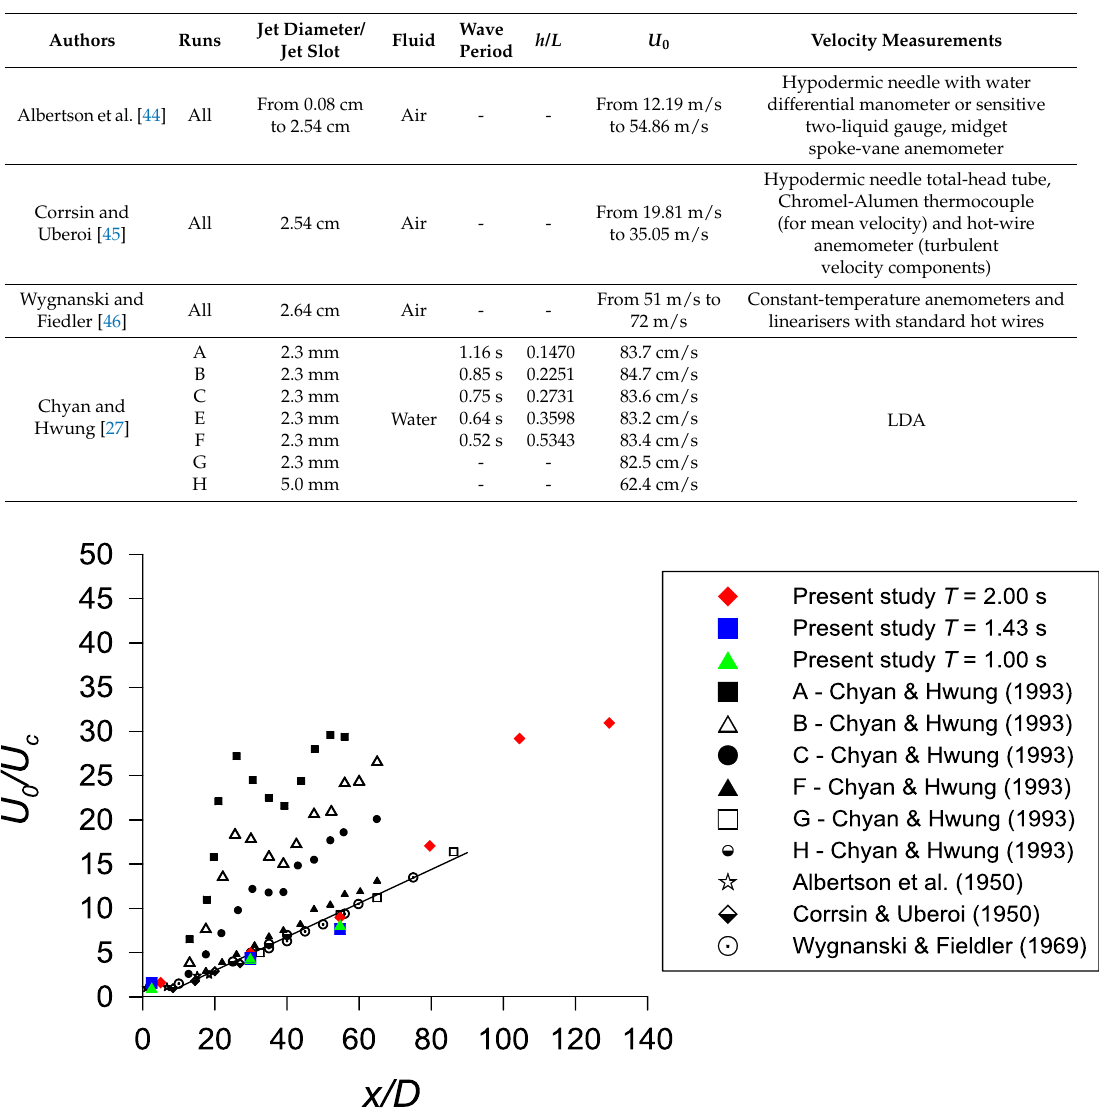
Figure 10. Values of U 0 /U c along the jet mean axis.